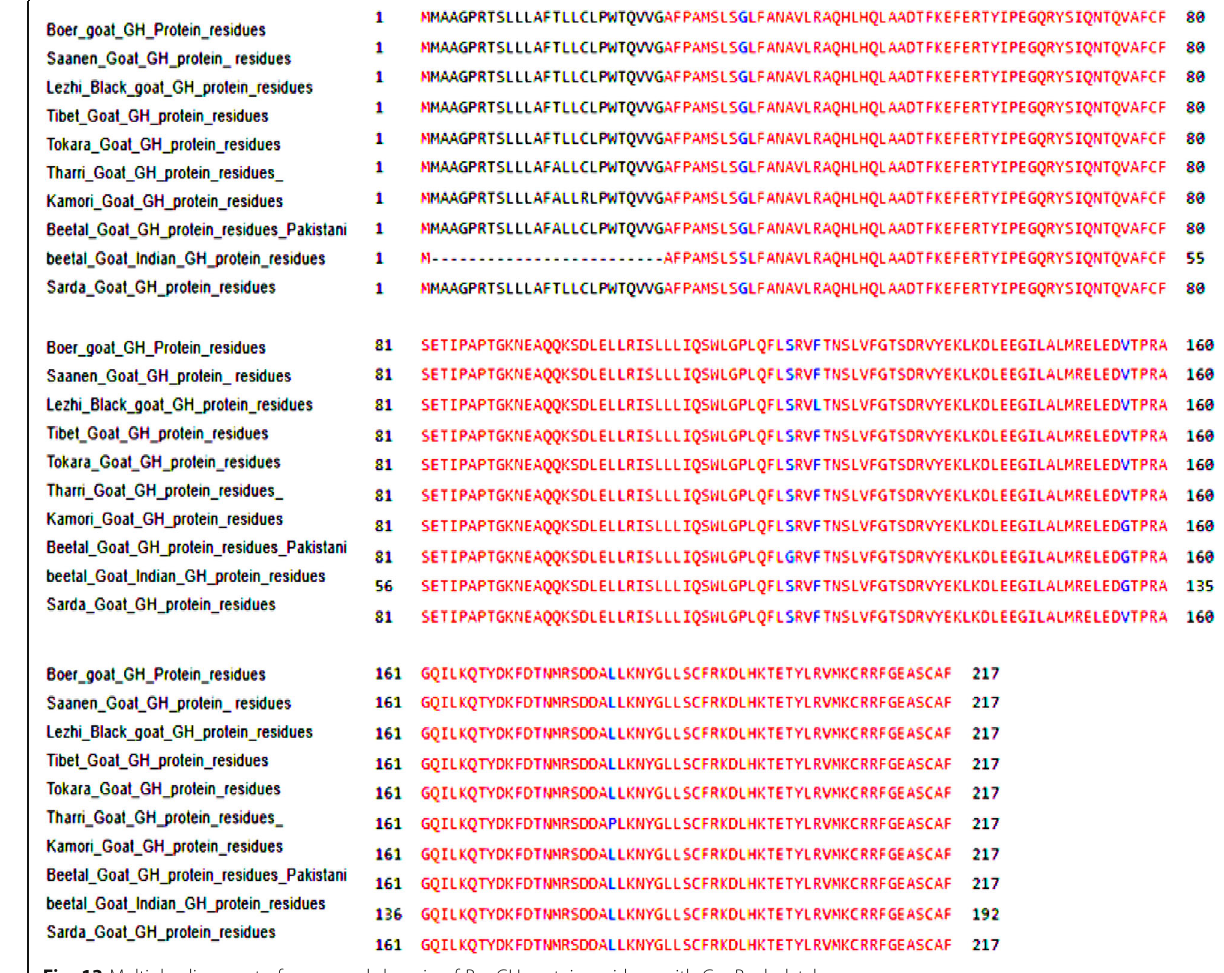
Fig. 13 Multiple alignment of conserved domain of Bo_GH protein residues with GenBank